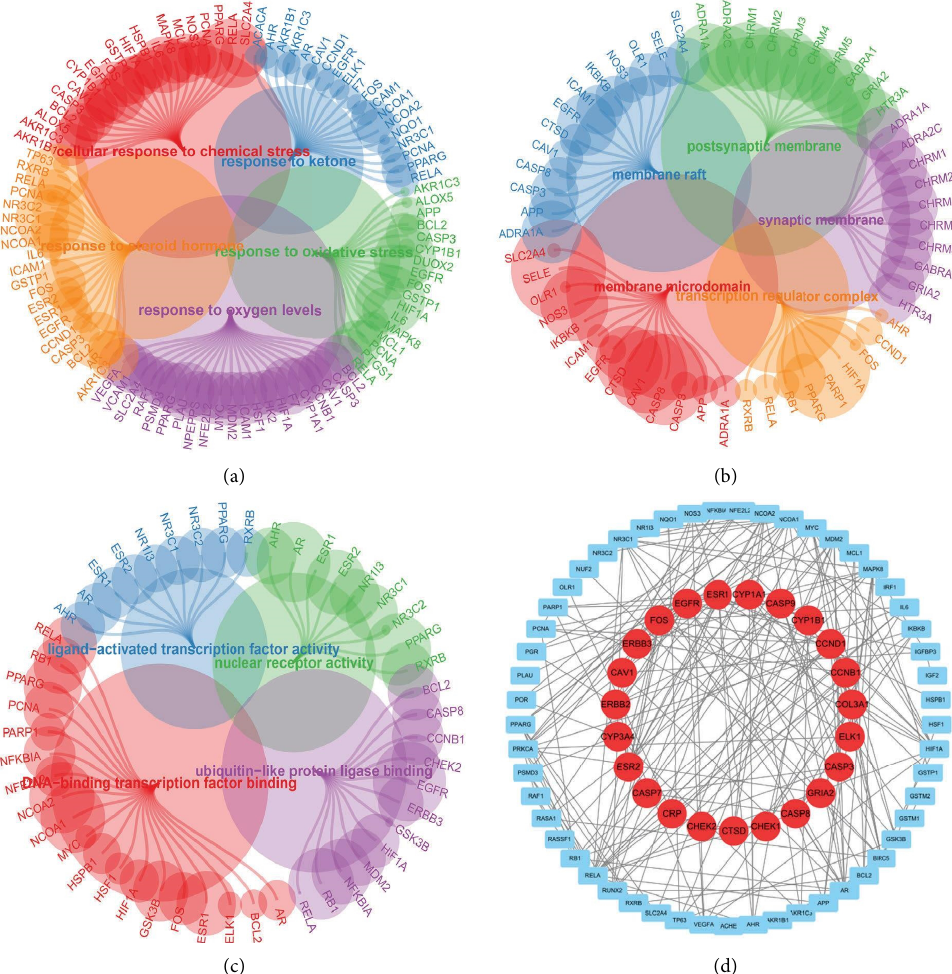
Figure 1: (a) GO BP enrichment analysis based on the SQDH-related genes. (b) GO CC enrichment analysis based on the SQDH-related genes. (c) GO MF enrichment analysis based on the SQDH-related genes. (d) PPI network based on the SQDH-related